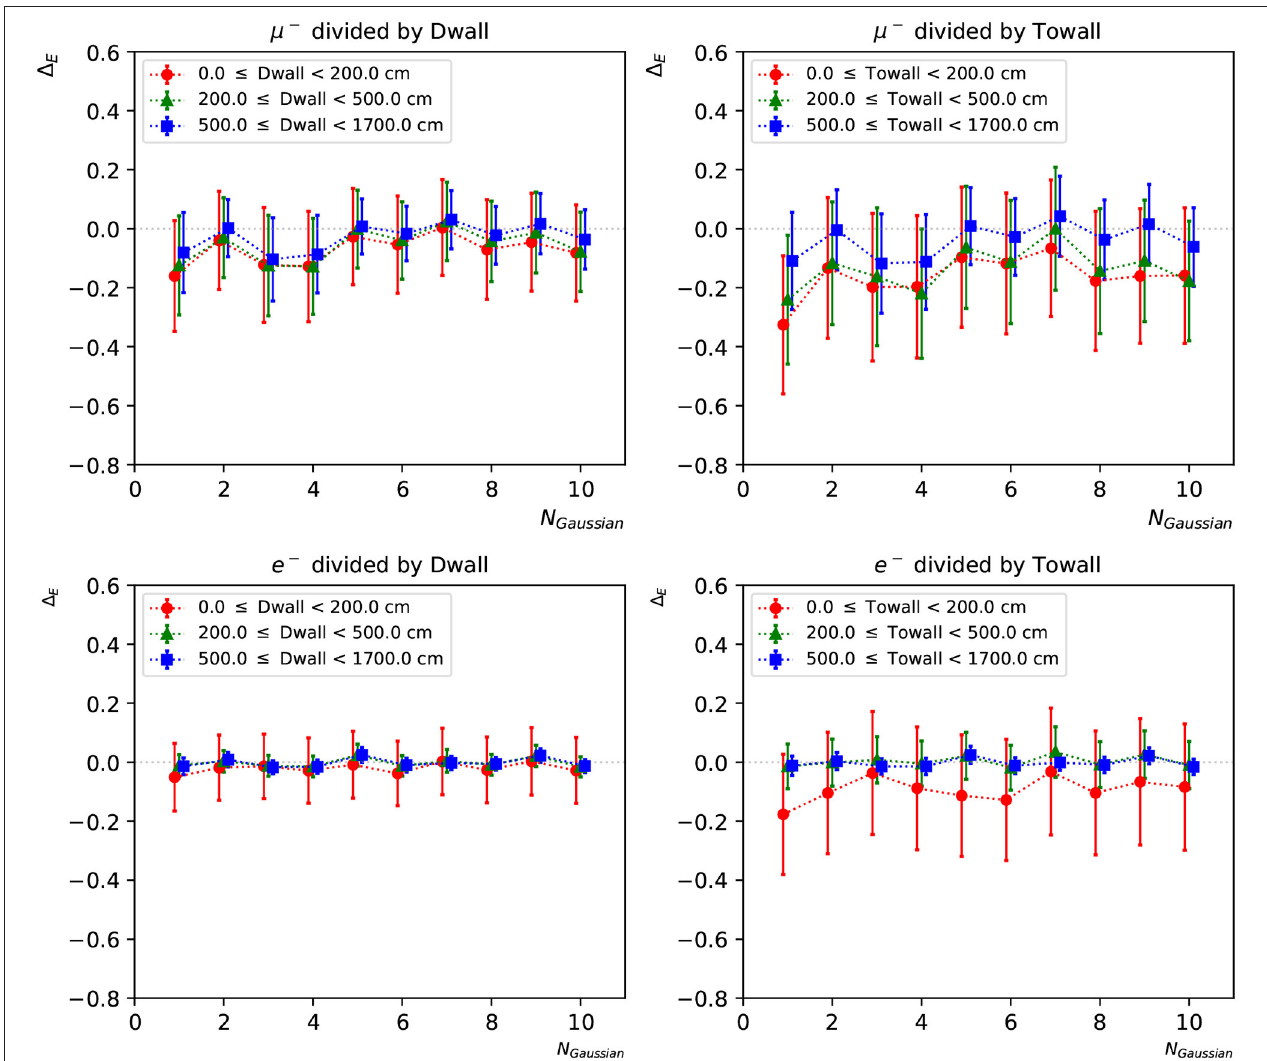
FIGURE 9 | The statistical mean 1 E of charge-only networks with 1 200 500, and 500 cm from the detector walls. The left column shows dependence of “dwall” and the right “towall”. Error bars represent the standard deviation of ∼ ≥ 1 E in each event set, which can be viewed as the energy